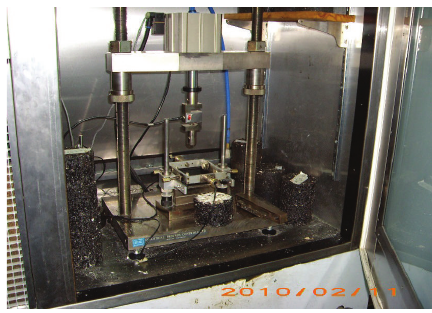
Figure 1: The testing machine (Universal Materials Testing Appara- tus (UMATTA)) and the CR-reinforced SMA